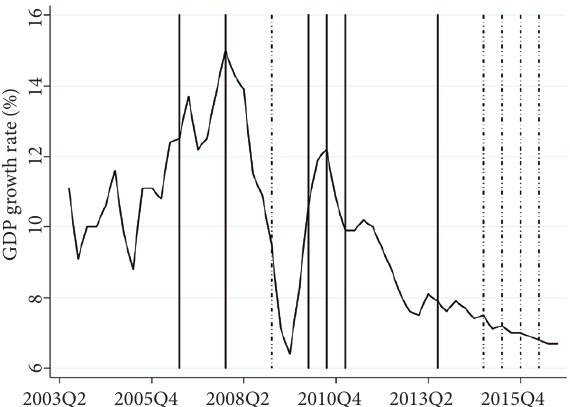
Figure 1. GDP growth rate and the down payment policy